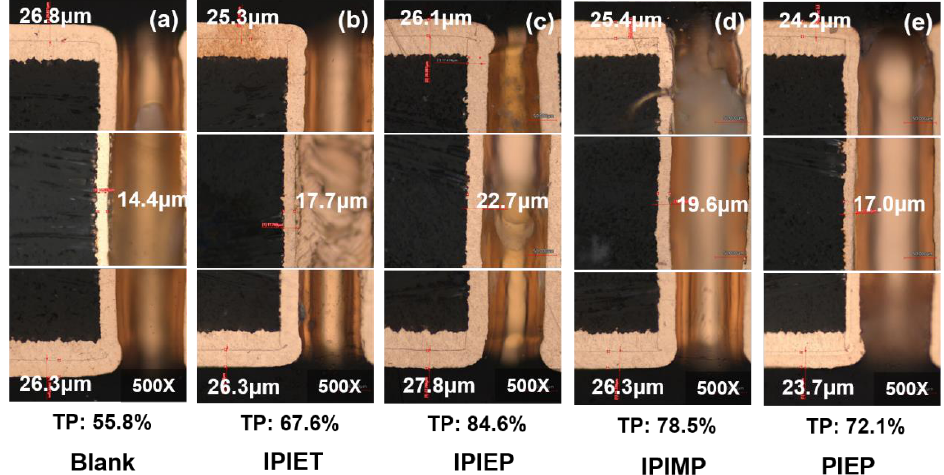
Figure 3. Cross-section metallographic photos of THs obtained from the base electrolyte with 500 mg/L PEG, 1 g/L SPS, and 5 mg/L oligomers: ( a ) without leveler; ( b ) IPIET; ( c ) IPIEP; ( d ) IPIMP; ( e )